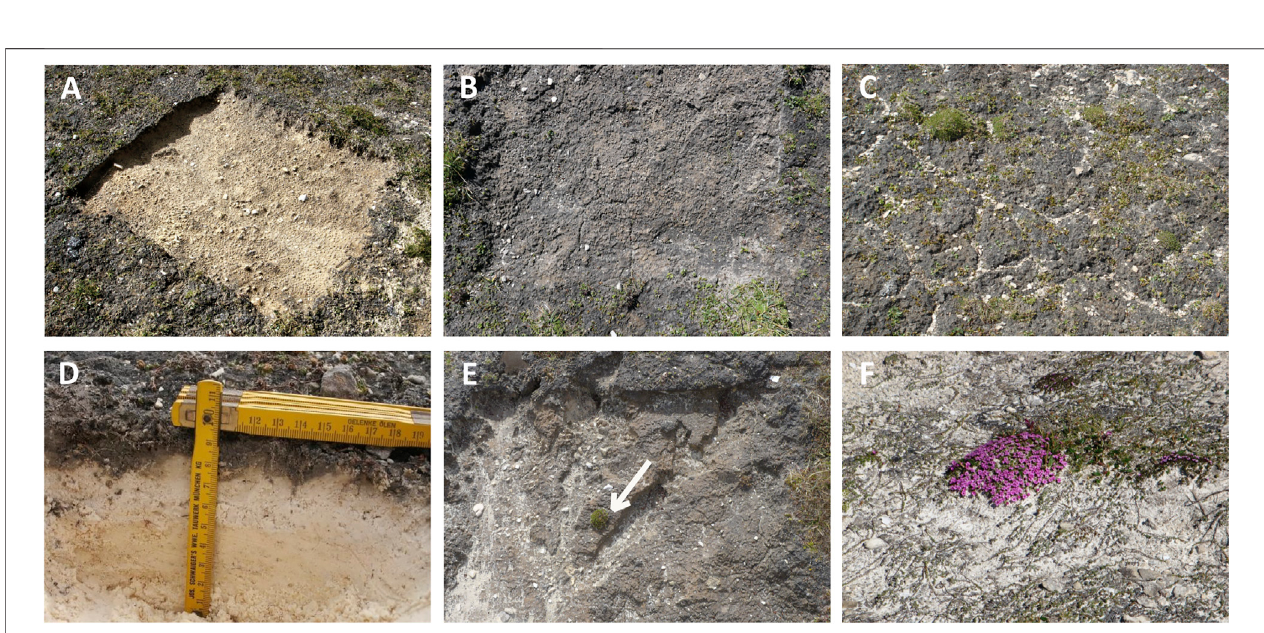
FIGURE 4 | (A) Highly disturbed treatment plot in 2012. (B) Treatment plot after 7 years (C) Frost affected biological soil crust. (D) Crusty Rendzic Regosol on Rauwacke. (E) Heavily eroded plot with a small cushion of Silene acaulis (arrow). (F) Plants covered with limestone dust. ® Thomas Peer.